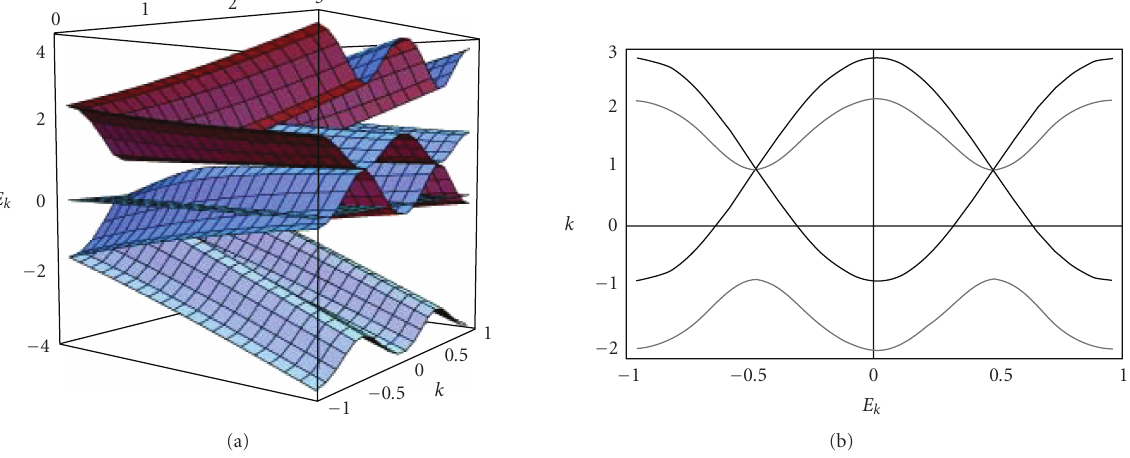
Figure 18: Energy bands of the decorated ladder model. (a) The energy bands as a function of V . (b) The snap shot of the energy bands when V = 1. k means the wave vector in units of π/s such that − 1 . 0 ≤ k ≤ 1 . 0, V means the π -electron hopping integral between the interchain sites, and E means the energy in units of V = 1. Here we have taken the values α = 1 . 0, β = 0, and a = b = 1.